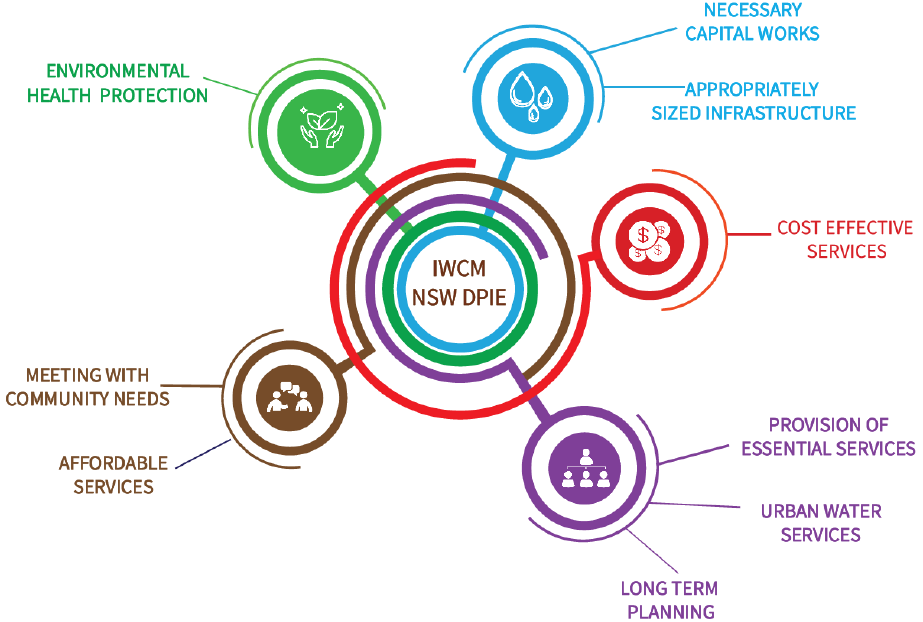
Figure 13. IWCM in New South Wales, Australia.